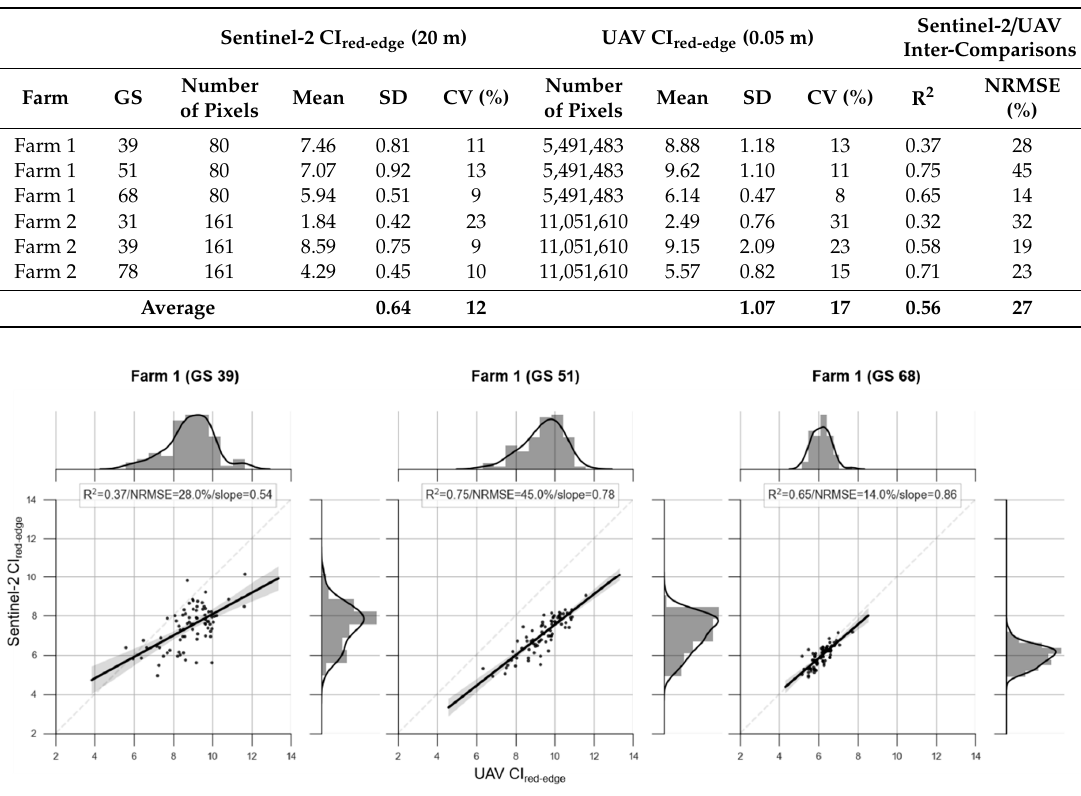
Figure 4. Scatter plot comparisons of the mean and distribution of CI red-edge values derived from coarse-scale Sentinel-2 and fine-scale UAV observations aggregated to 20 m for Farm 1. This includes slope values used to quantify bias and a dashed gray line representing the 1:1 line. Joint histograms of values from both sensors include the kernel density fit (solid black line).